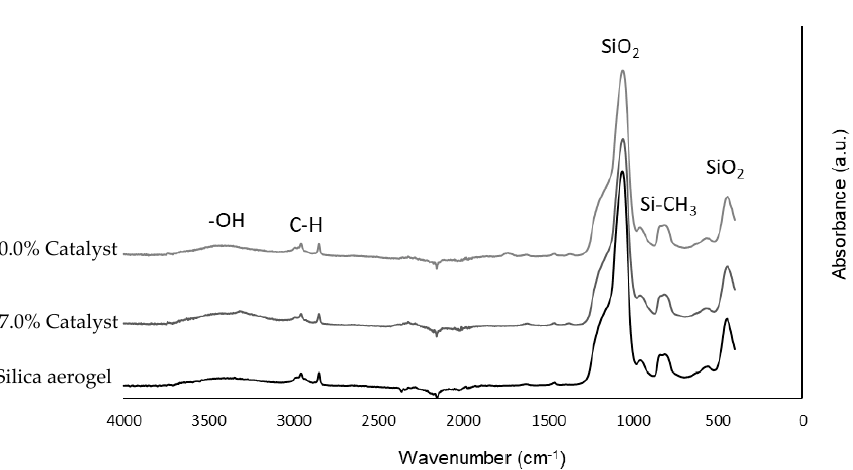
Figure 5. UV-Vis absorption spectra of ZnO/Cu catalyst.